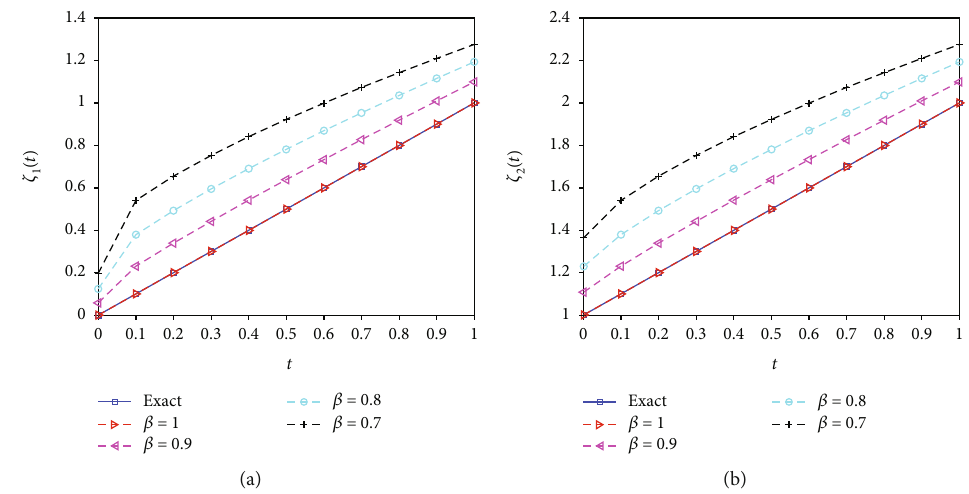
ð t Þ are shown. In (b), the numerical 1 ð t Þ are shown. 2